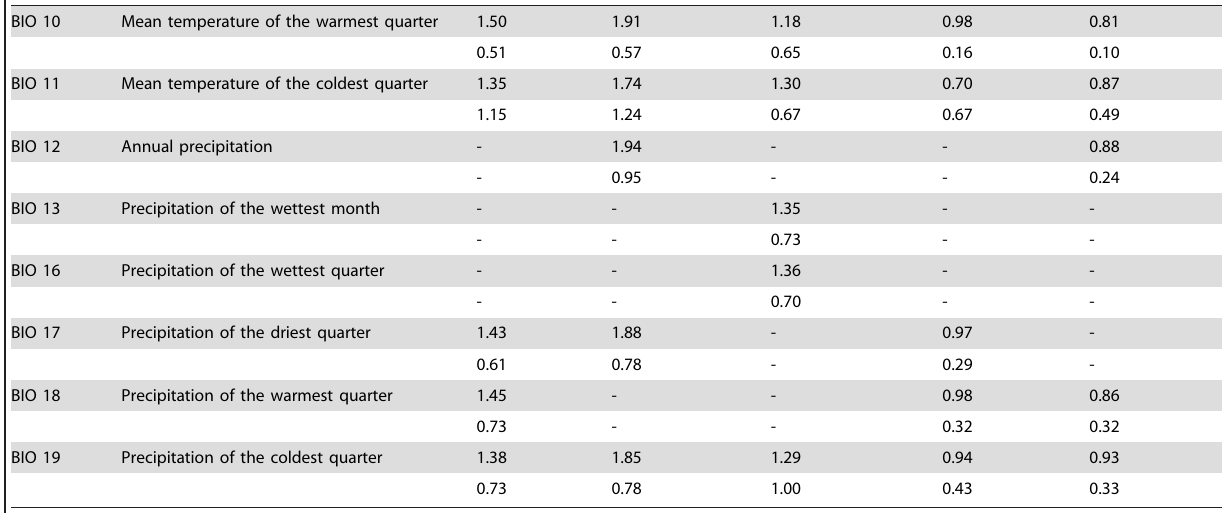
algorithm implemented in MaxEnt software computes a